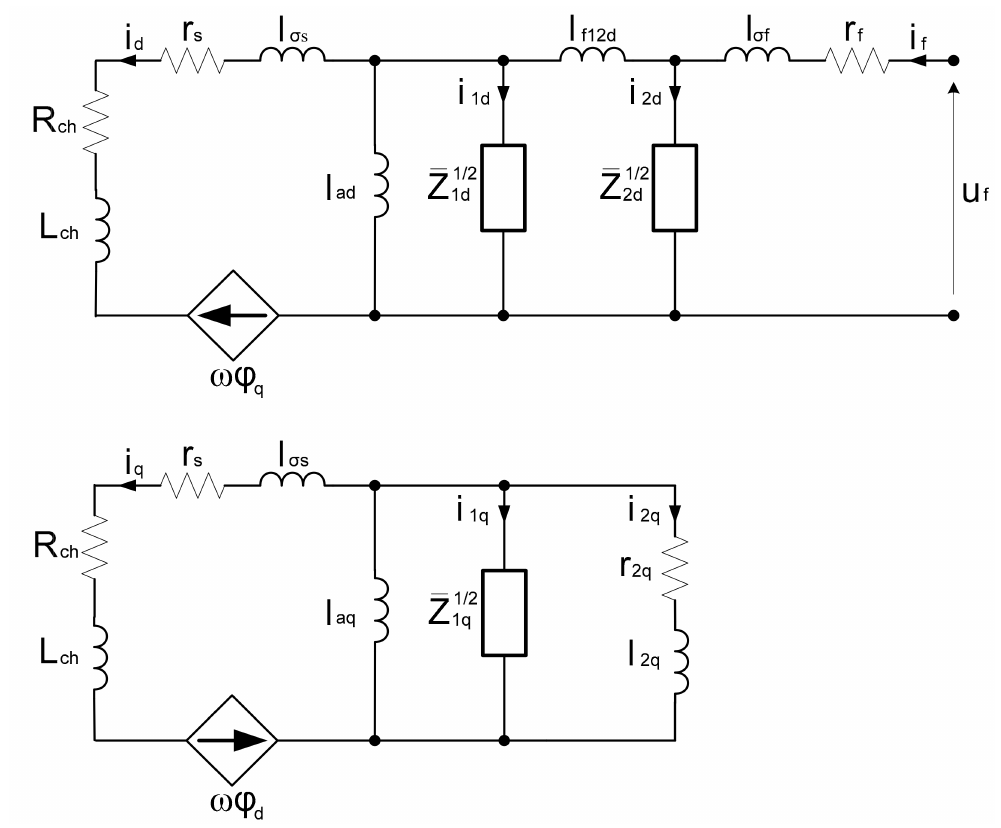
Figure 2. Non-integer order equivalent circuits of a synchronous generator connected to RL electric load (axes d and q